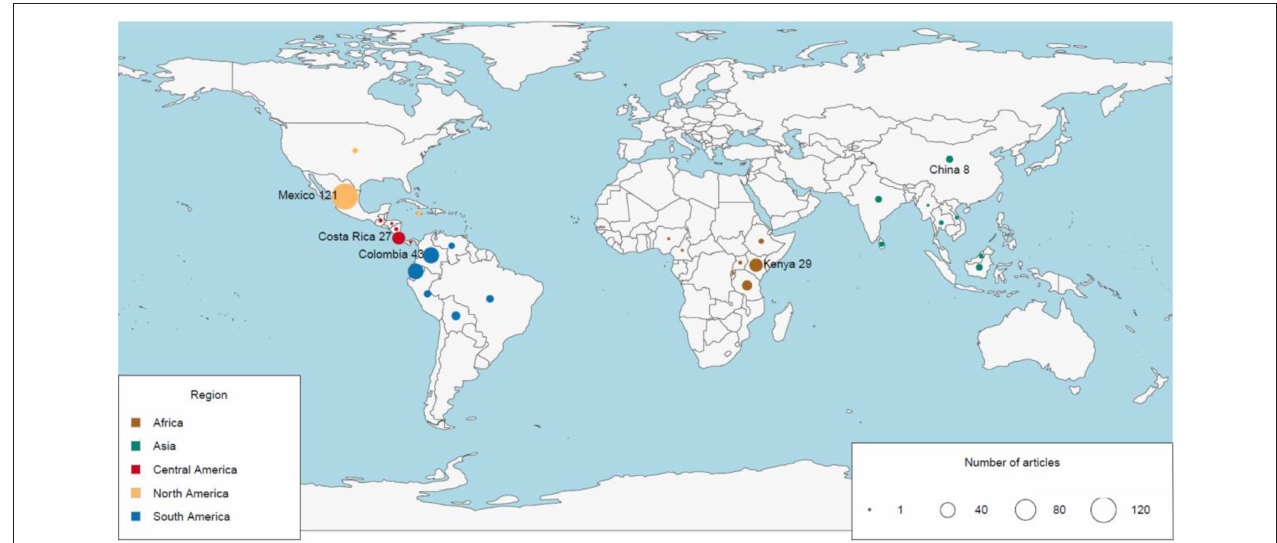
FIGURE 3 | Map of the number of articles published from 1991 to 2018 on the impacts of habitat degradation on tropical montane biodiversity in different countries. The diameter of the circles is directly proportional to the number of published articles. Country names represent the highest number of articles published in the region.